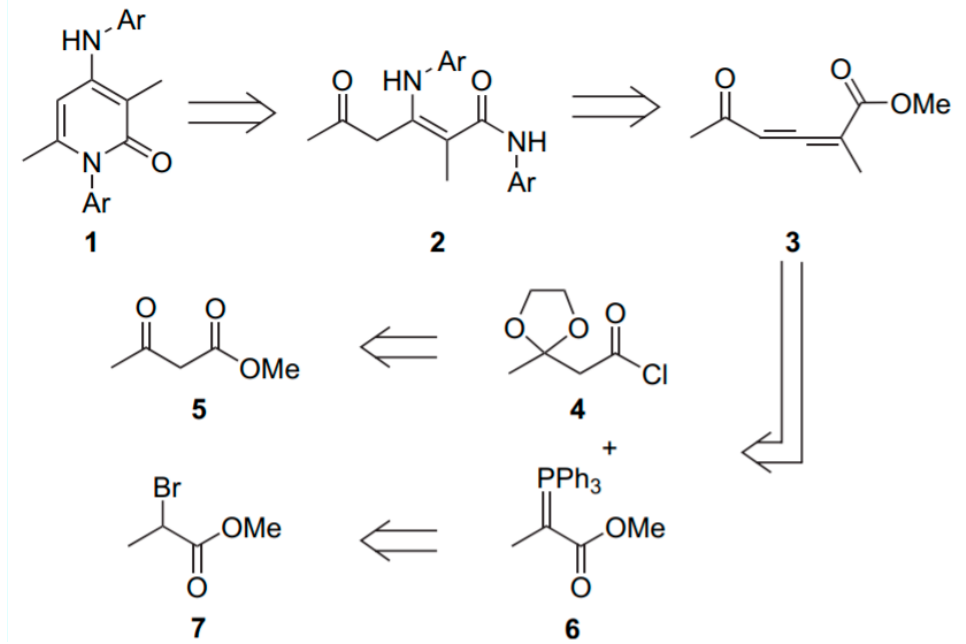
Figure 8. General pathway of PYR synthesis.